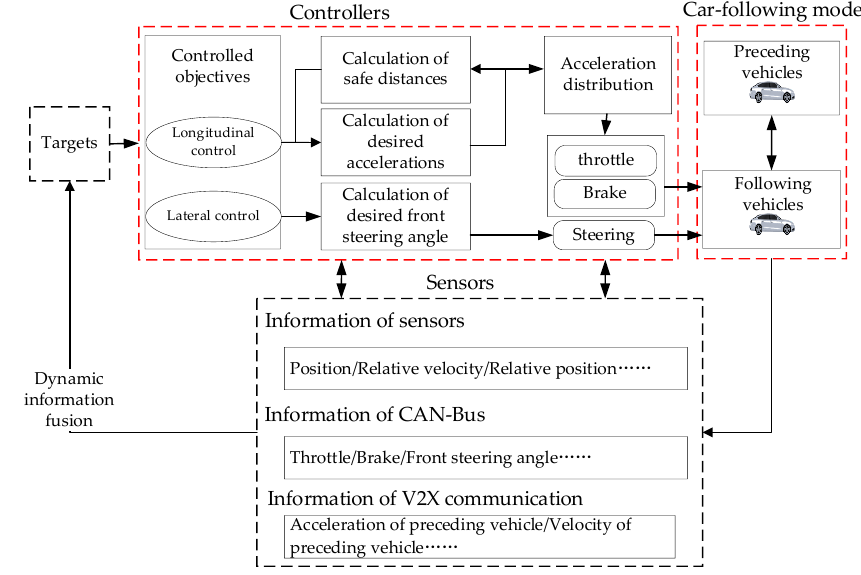
Figure 1. The framework of the cooperative car-following system based on eco-driving.